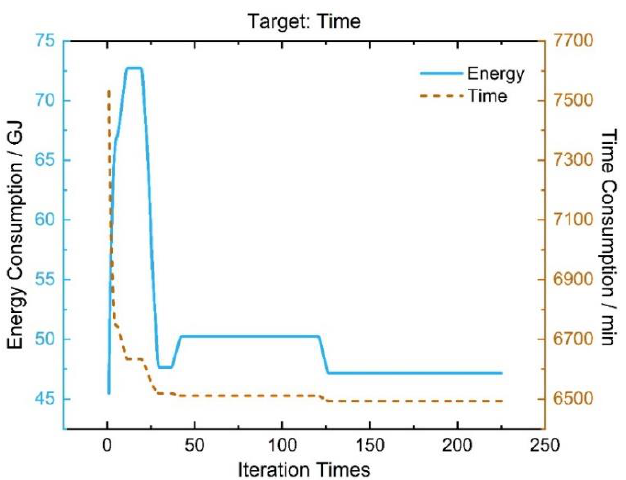
Figure 5. The change in time and energy consumption when thinking more about the time parameter in the iterative process.